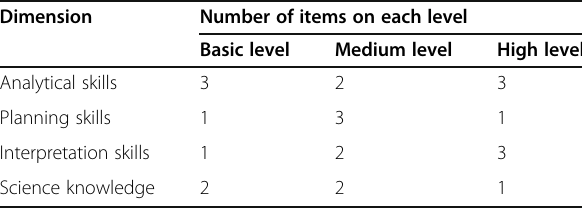
Table 3 Overview of SIT-PE test items Dimension Number of items on each